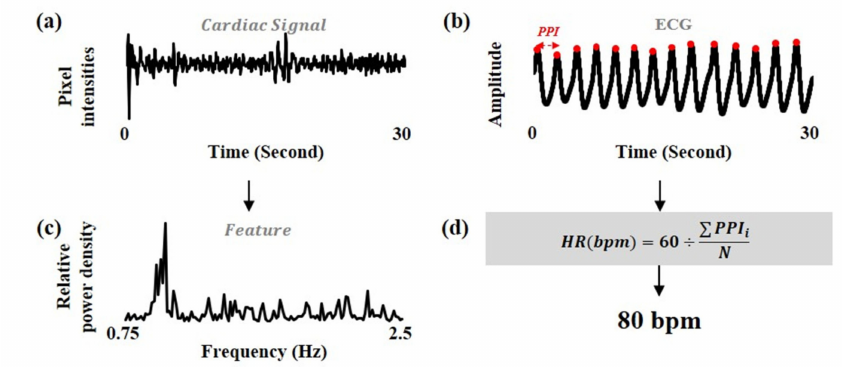
Figure 2. Overview of feature extraction. ( a ) cardiac signal estimated from facial video by signal extraction and signal estimation, ( b ) electrocardiogram (ECG) signal, ( c ) relative power density (RPD) extracted from the cardiac signal by fast fourier transform (FFT) and normalization and determined as features, ( d ) heart rate calculated from the ECG signal by the QRS detection algorithm and determined as